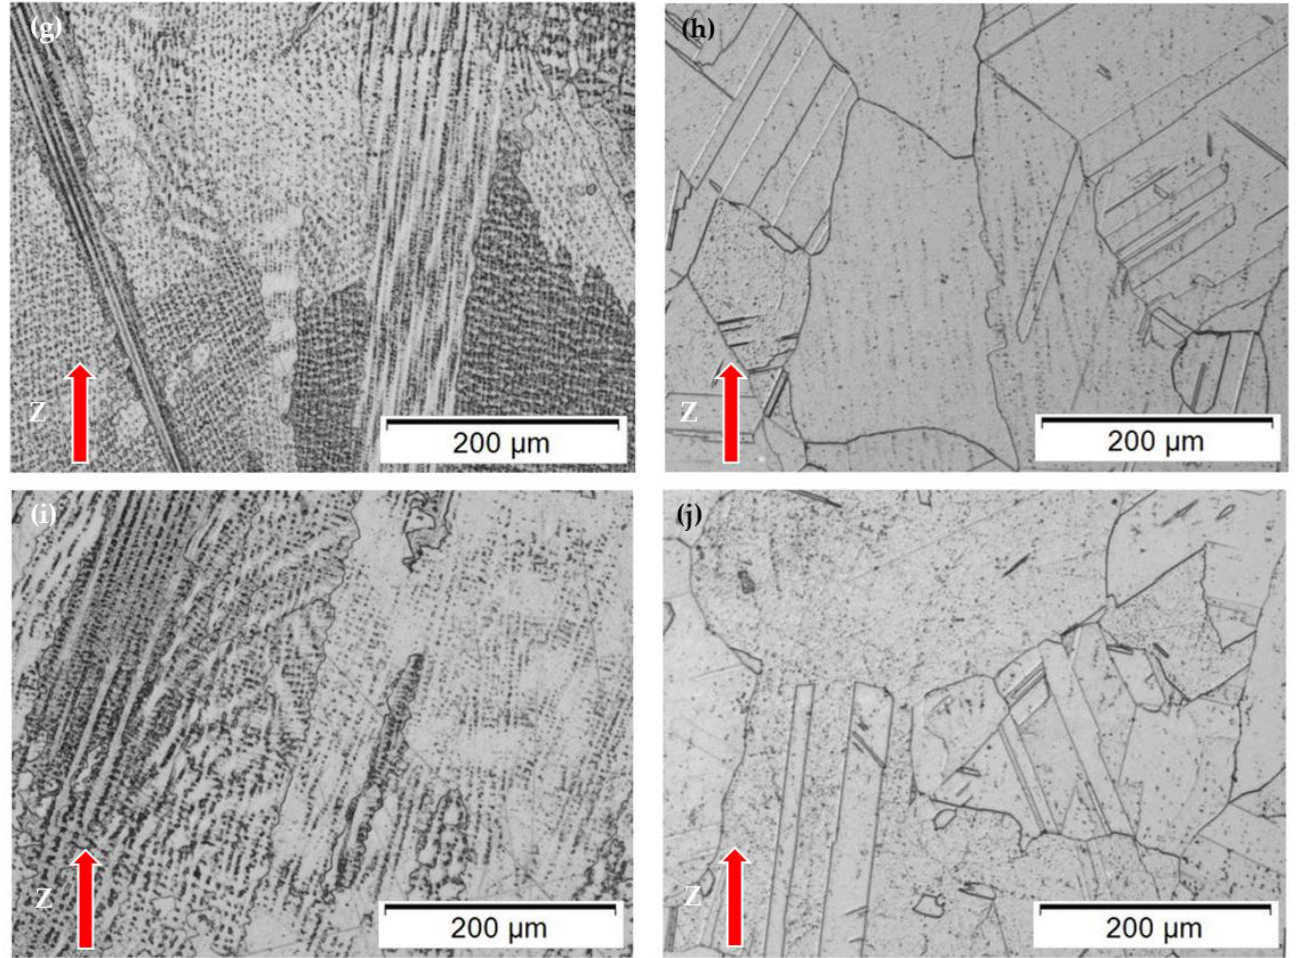
Figure 6. LP-DED optical microscope images: ( a ) 350 W as-built, ( b ) 350 W heat-treated, ( c ) 750 W as-built, ( d ) 750 W heat-treated, ( e ) 1070 W as-built, ( f ) 1070 W heat-treated, ( g ) 2000 W as-built, ( h ) 2000 W heat-treated, ( i ) 2620 W as-built, ( j ) 2620 W heat-treated.